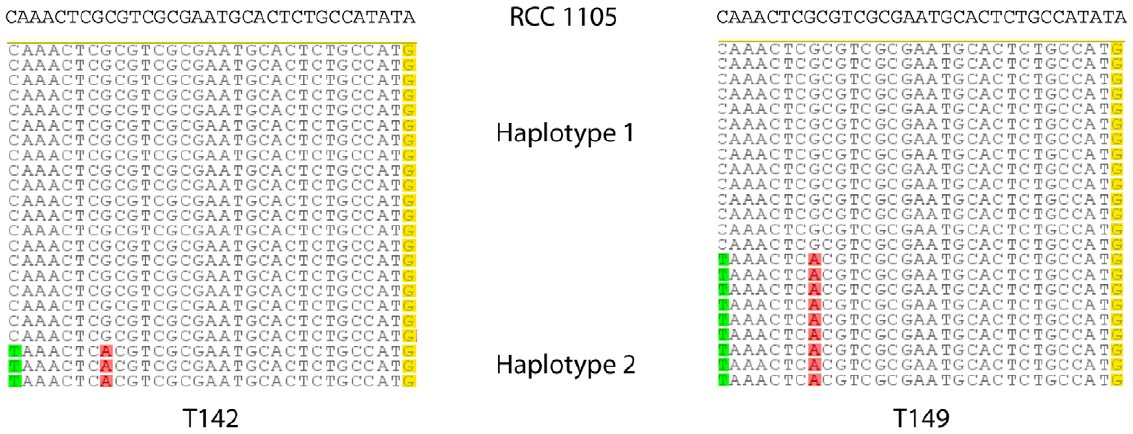
Figure 3. Genotypes observed for B.prasinos RCC1105 gene Bathy02g01050 (pigment synthesis protein, BOGAS annotation code) for samples T142 (left) and T149 (right). At least two different sequences appear to be present in both samples, differing by one and three positions, respectively, from the reference B.prasinos RCC 1105 sequence. Only 23 representative reads are shown for each sample although more reads covered this region (see Table